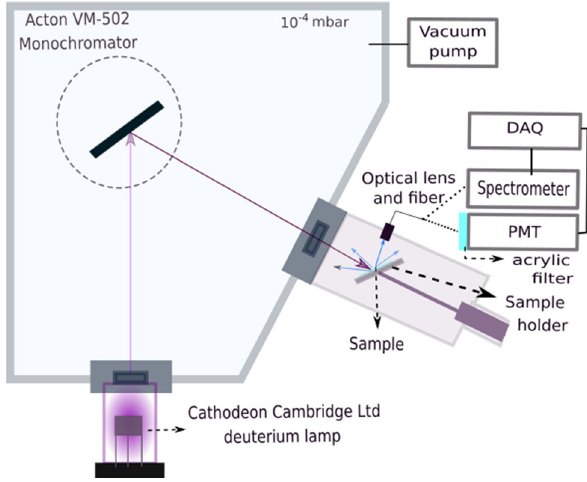
Fig. 5 Schematic drawing of the fluorescence measurement setup. Light from the deuterium lamp is directed through an entrance slit toward the monochromator, which reflects the desired wavelength toward an adjustable exit slit and onto the sample. The sample is placed in a movable sample holder so that the incident angle can be varied. An optical fiber collects light reflected and re-emitted from the sample and guides it to the light detectors. The whole system is under vacuum so that the VUV light is not